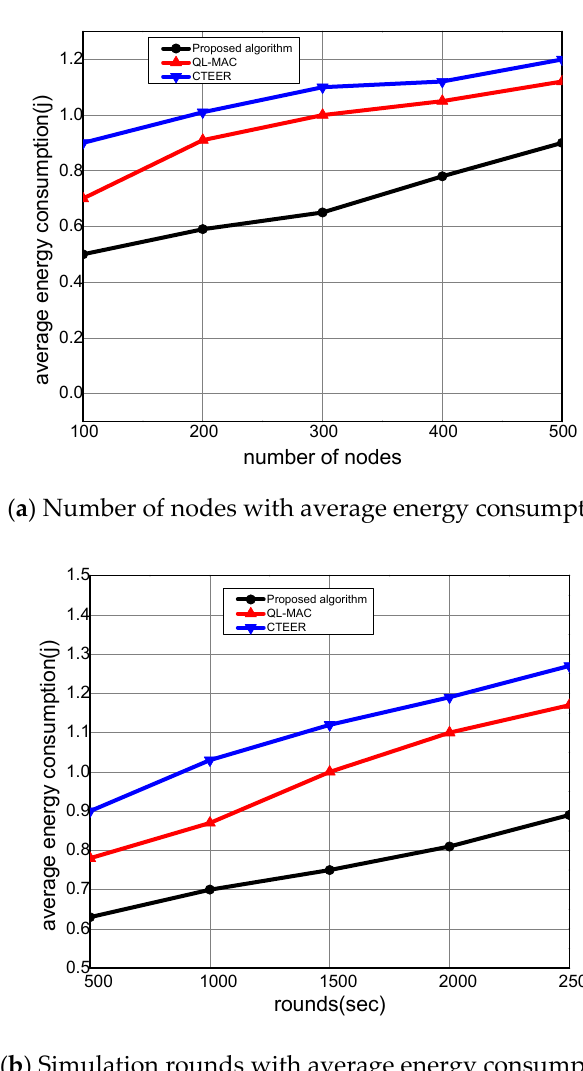
Figure 9. The performance evaluation of the proposed algorithm compared to QL-MAC and CTEER for average energy consumption.